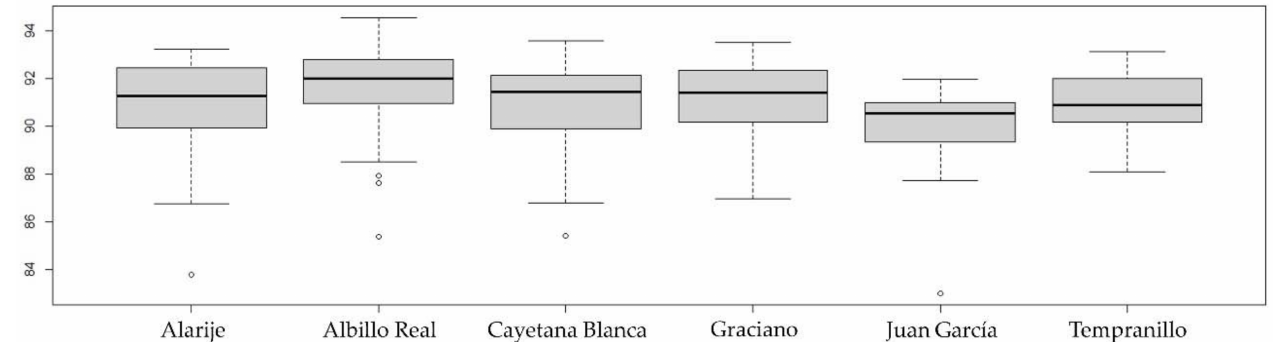
Figure 9. Box-plot representations showing the distribution of J index values in the cultivars Alarije, Albillo Real, Graciano, Juan Garc í a and Tempranillo with the Albillo Real model.